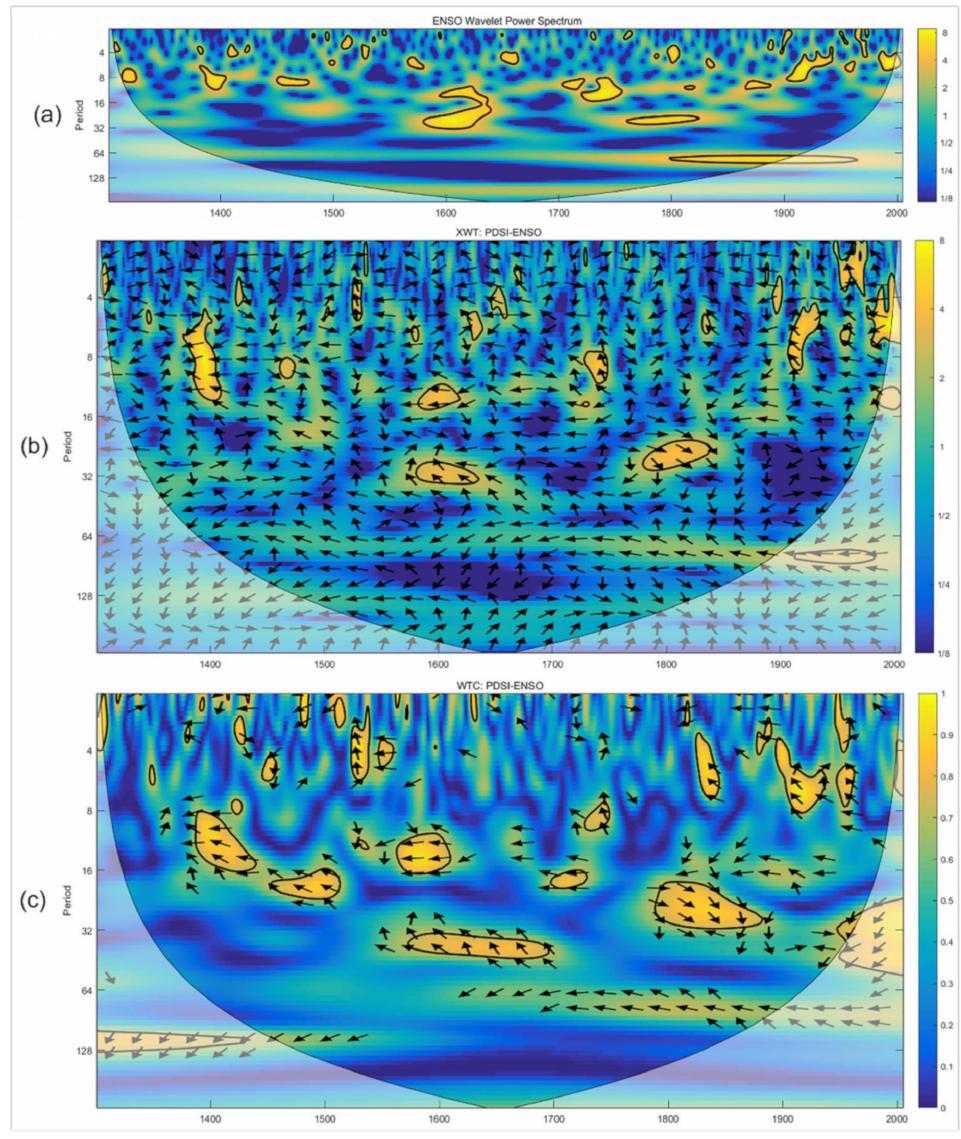
Figure 8. Results of ( a ) wavelet power spectrum, ( b ) cross wavelet (XWT), and ( c ) wavelet coherence (WTC) between the PDSI and ENSO series. Graphic illustration can refer to Figures 6 and